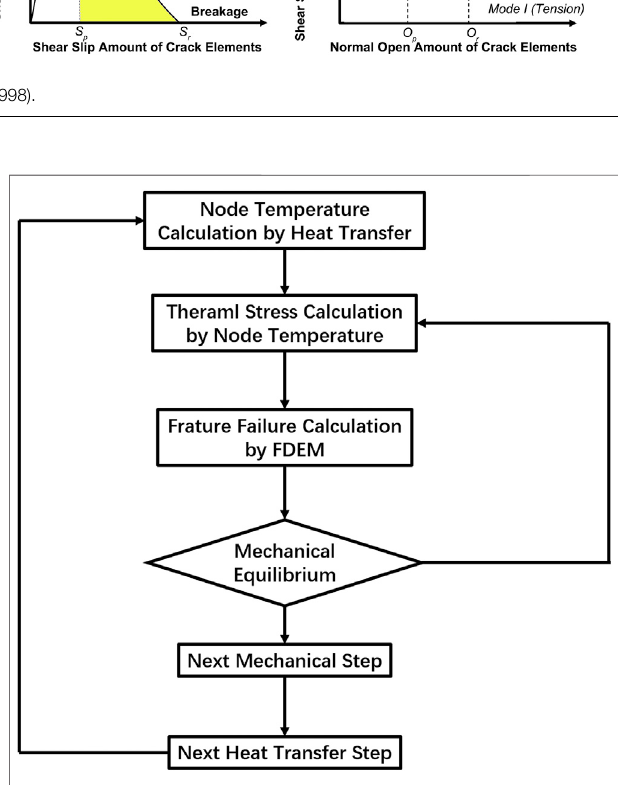
FIGURE 3 | Flowchart of sequentially thermal